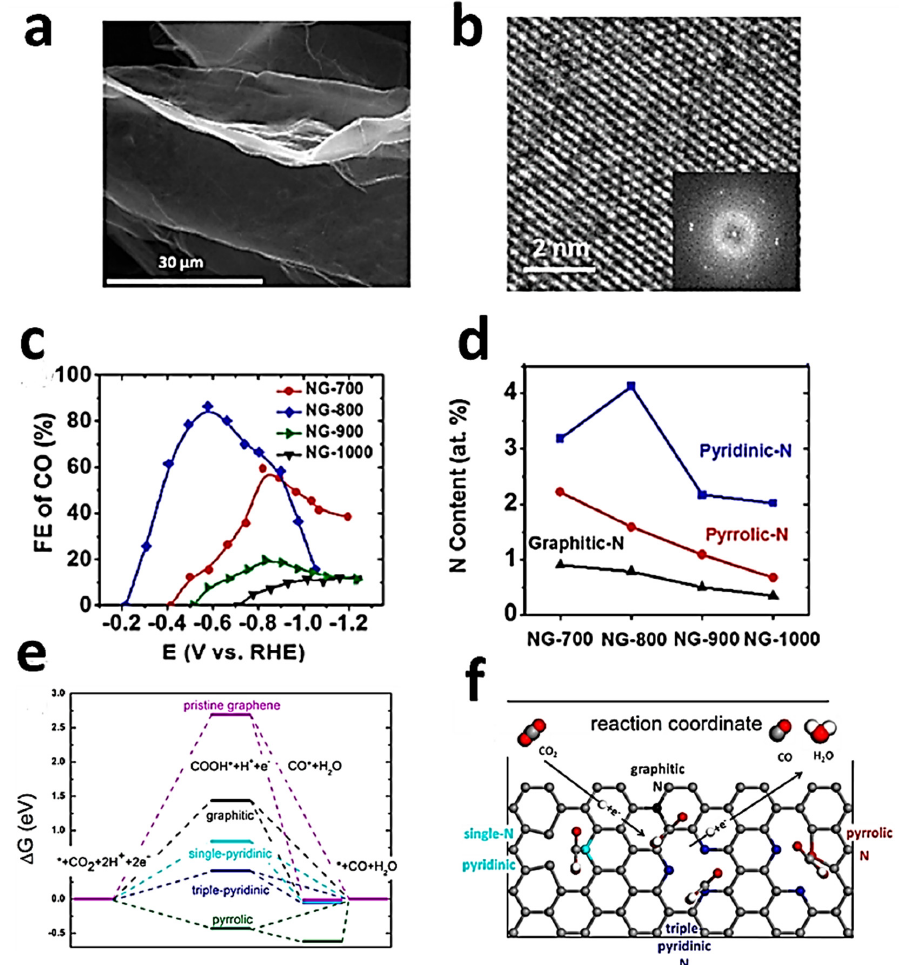
Figure 24. ( a , b ) SEM and TEM images of N-doped 3D graphene foam. ( c ) Faradaic efficiency of CO production vs. potential on N-doped 3D graphene doping temperatures of 700–1000 °C. ( d ) The corresponding N functionality content. ( e ) Free energy diagram of electrocatalytic CO 2 reduction on N-doped 3D graphene and ( f ) schematic of N configuration and CO 2 reduction mechanism. Reproduced with the permission from [234].